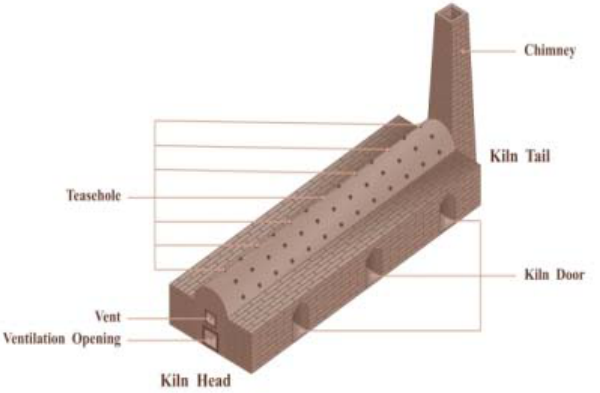
Figure 4. Internal configuration of Steamed Bun Kiln.